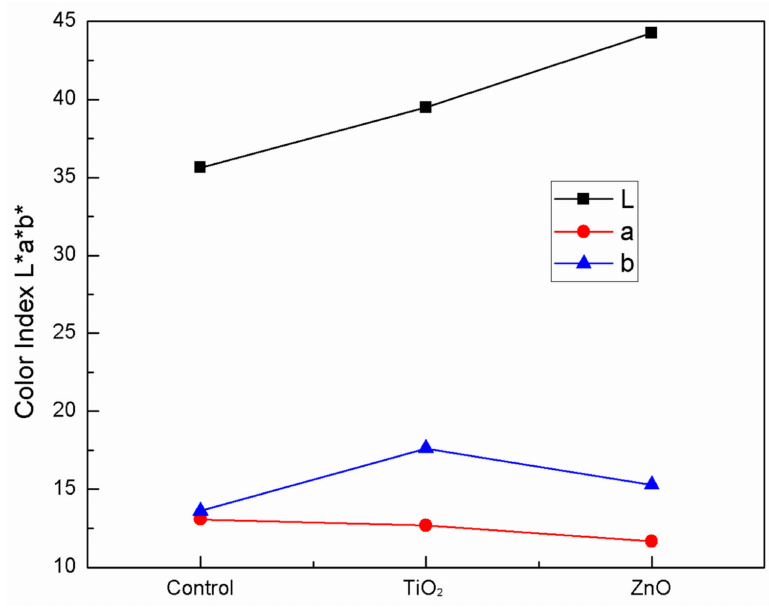
Figure 2. Changes of wood color index before and after surface modification.